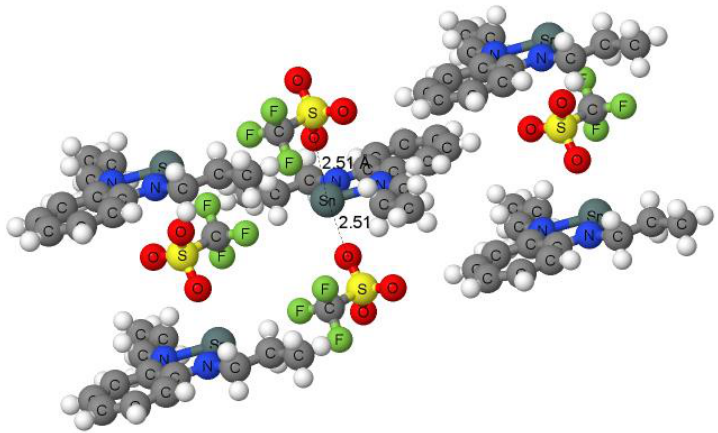
Figure 2. The fragment of the crystal structure of (N-(n-propyl)-2-(n-propylamino)troponiminato- N,N ’ )-tin(ii) trifluoromethanesulfonate. The closest intermolecular contacts are indicated.